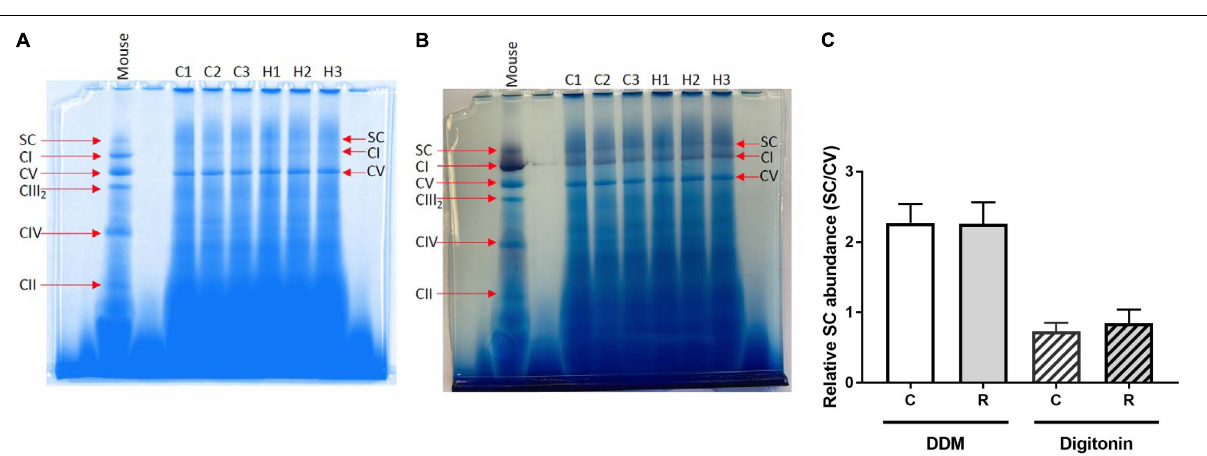
FIGURE 5 | Resolution of mitochondrial ETS complexes of M. edulis . BN-PAGE of ETS complexes (CI-CV) along with supercomplexes (SC) from M. edulis mitochondria solubilized with DDM or digitonin, with mouse mitochondria (left) used for comparison to identify bands. (A) image of the gel with DDM-treated samples, (B) image of the gel with digitonin-treated samples, and (C) – quantification of the SC band intensity relative to CV band C - control, R - reoxygenation. The gels were stained for protein (blue) and Complex I activity (purple) of three biological replicates (C1-3, controls and H1-3, after H/R